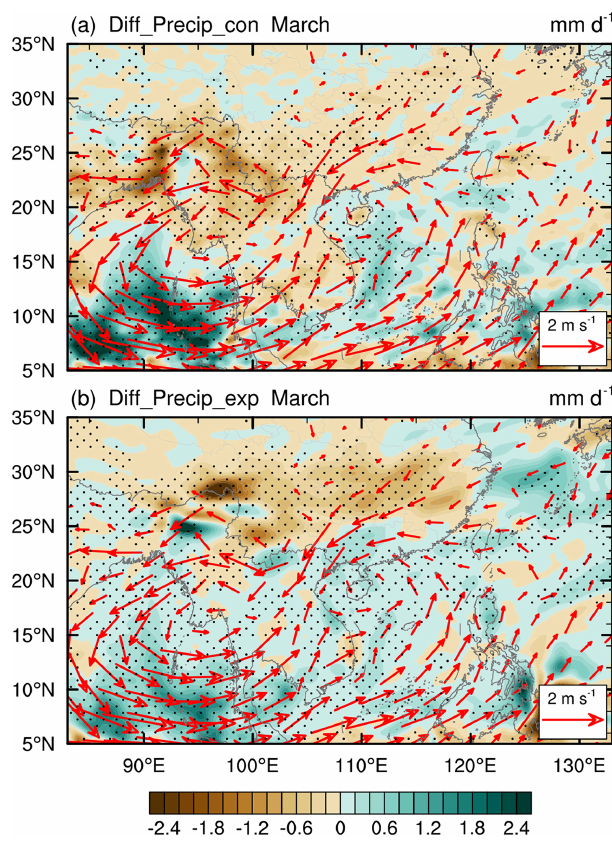
Figure 11. Differences (CTRL minus BBER) in (a) convective pre- cipitation and (b) non-convective precipitation (shading; mmd − 1 ) in March 2010 together with the 850hPa wind difference (vector; ms − 1 ). Stippling and the red vector denote that precipitation and wind are statistically significant at the 95% confidence level, re- spectively, based on a Student’s t